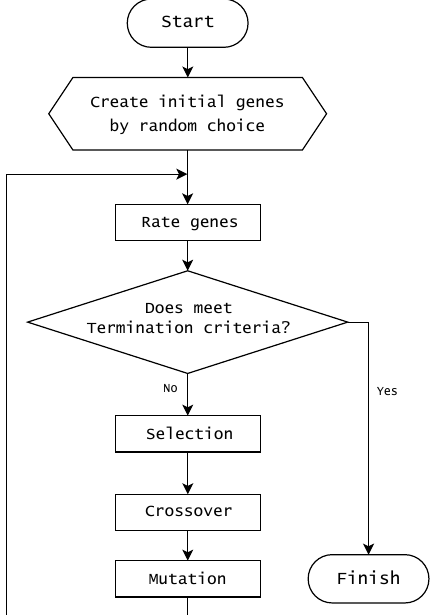
Figure 2. Simplified flowchart of the genetic algorithm’s